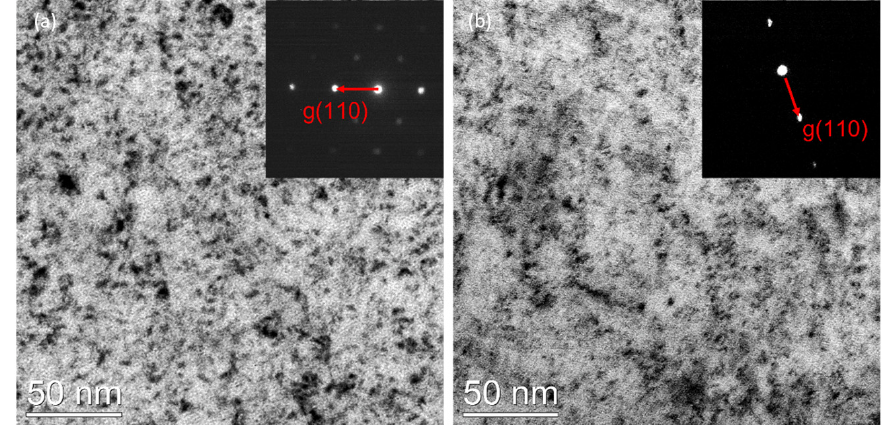
Figure 4. TEM images of radiation-induced dislocation loops in ( a ) V-4Cr-4Ti and ( b ) V-4Cr-4Ti-2Y.